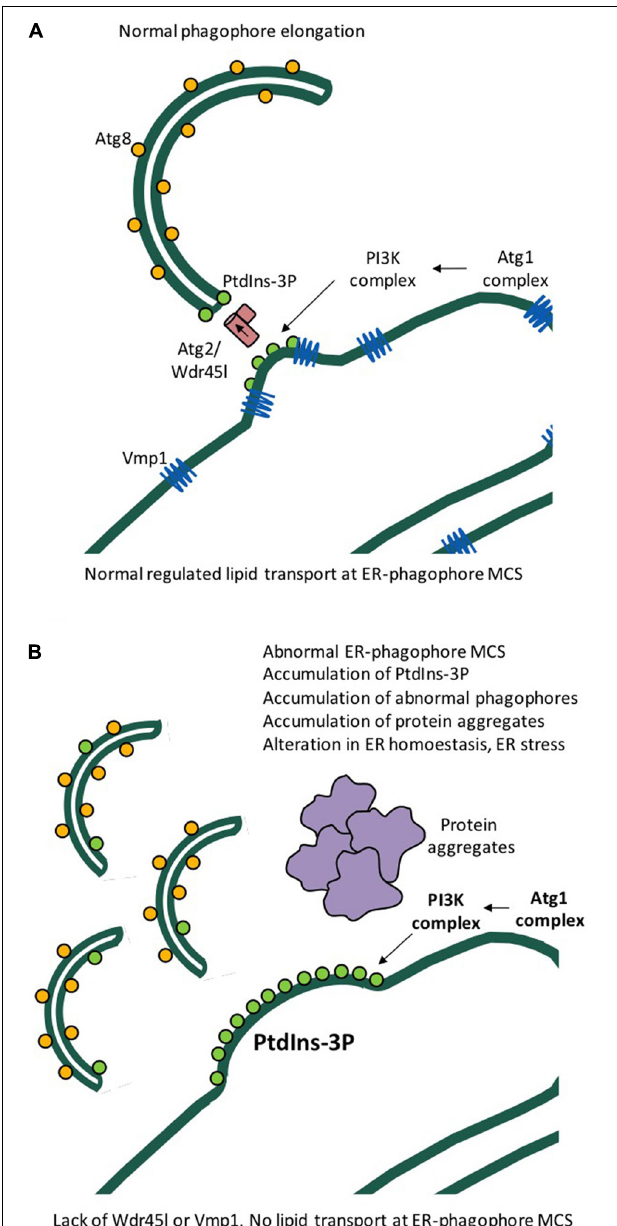
FIGURE 5 | Model of phagophore expansion and the function of Dictyostelium Wdr45l and Vmp1. (A) Lipid transport and phagophore elongation from the ER occur at membrane contact sites (ER-phagophore MCS) and require Atg2, Wdr45l, and Vmp1. (B) Cells deficient in Vmp1 or Wdr45l have similar phenotypes, including the accumulation of PtdIns3P, abnormal autophagic structures, and formation of protein aggregates. Abnormal accumulation of PtdIns3P leads to chronic ER stress and cell growth arrest. These defects are rescued by inhibition of the upstream signaling protein